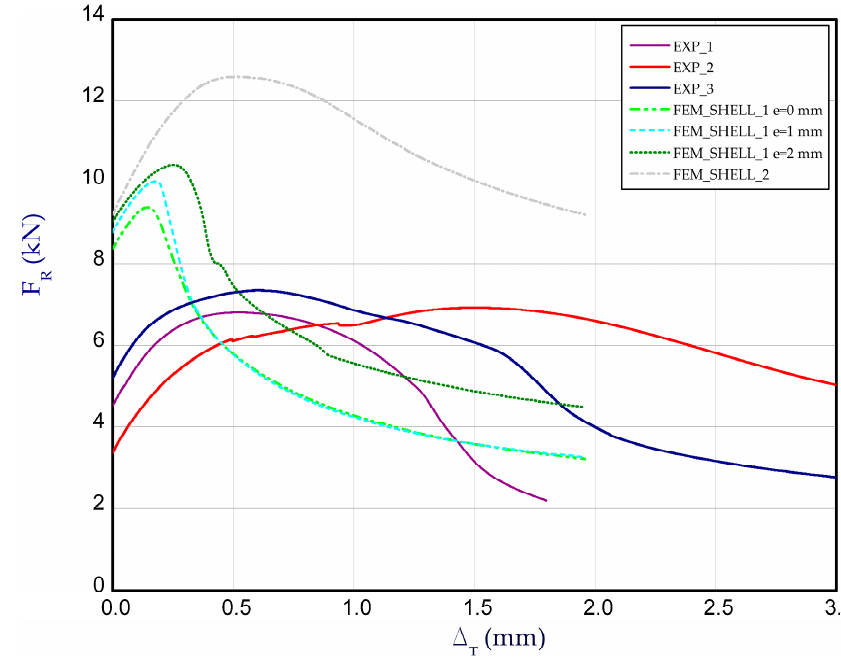
Figure 19. The compression curves of column at 150 °C.